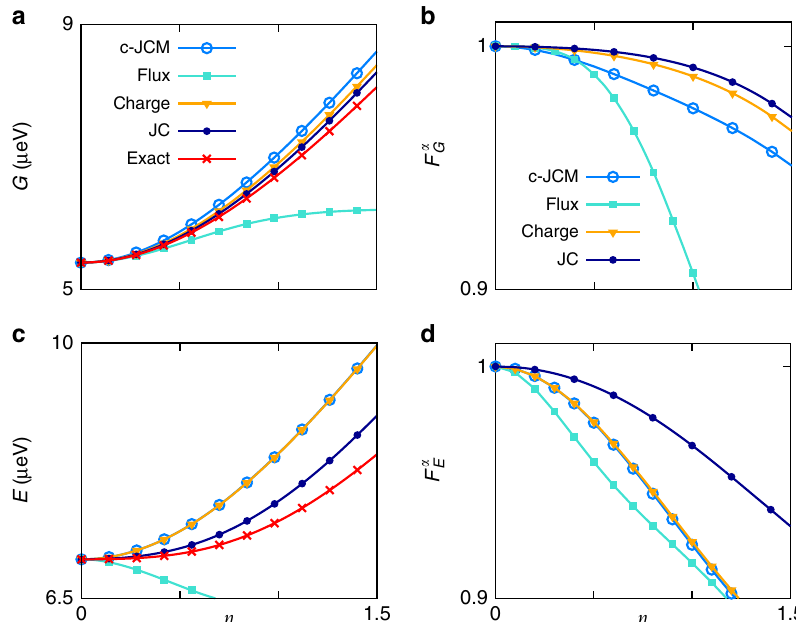
Fig. 3 Lowest energies and eigenstate fi delities as functions of coupling strength. In all plots, E l = 0.33 μ eV, E J = 10 E l = E c , δ = 5 and ϕ ext = π /2 e . a The ground energy is plotted with η for the fl ux-gauge and charge-gauge QRMs, for the JC-gauge two-level model, for the exact model and for the charge-gauge JCM obtained via the RWA. The fl ux-gauge JCM is extremely inaccurate in this regime and is not shown. b The ground-state fi delity F α G is plotted with η for the fl ux-gauge α = 1 and charge-gauge α = 0 QRMs, for the JC gauge and for the charge-gauge JCM (c-JCM) that is obtained as the RWA of the corresponding Rabi model. c Same as ( a ) for the fi rst excited energy. d Same as ( b ) for the fi rst excited state. For the excited state, the RWA remains